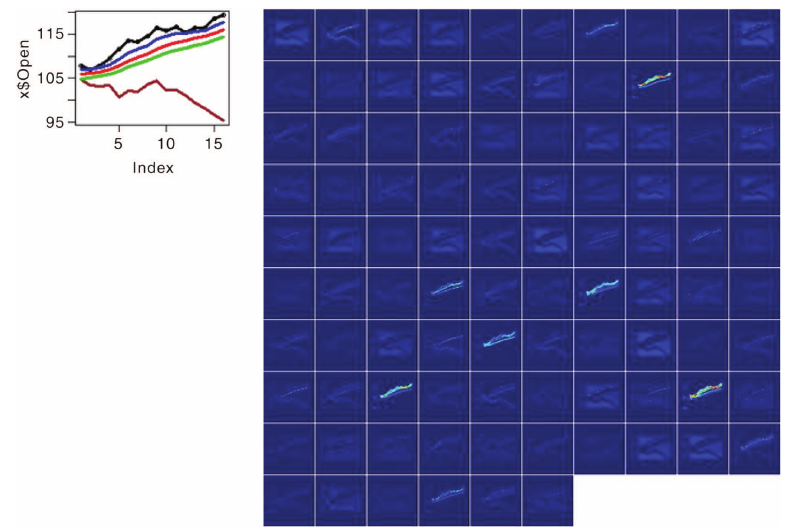
Figure 37: Visualization of the First Convolution Layer with the Demo Image.